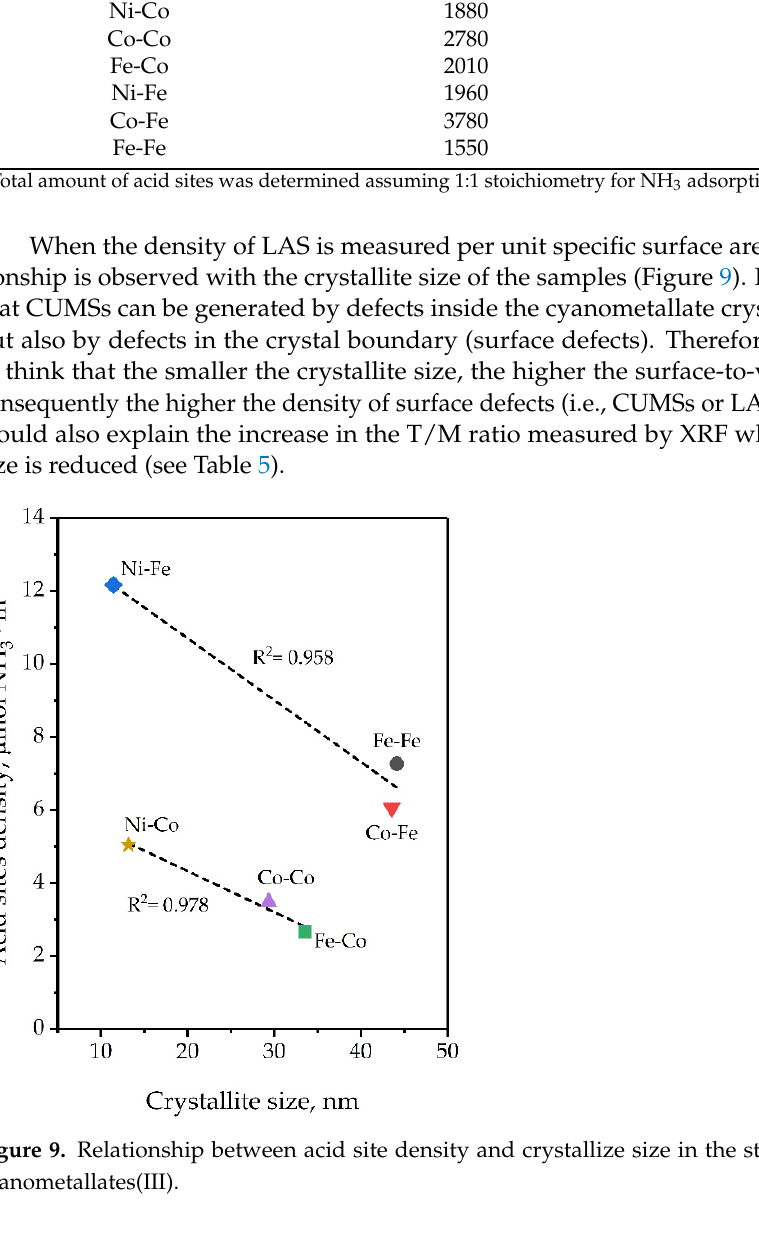
Table 8. Acid properties of the studied hexacyanometallates(III).